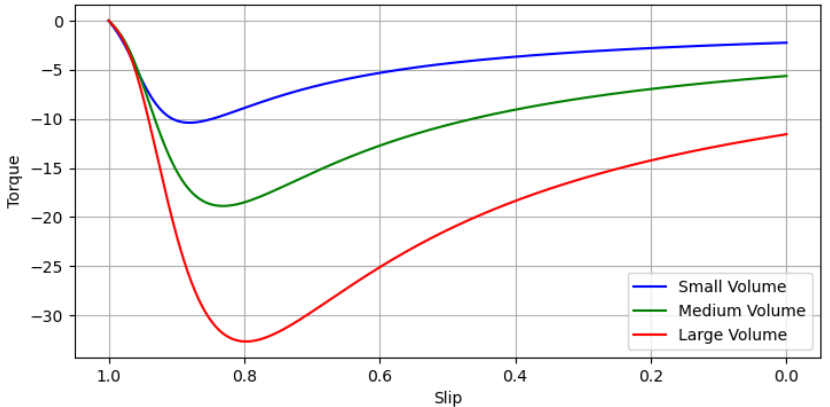
Figure 3. Braking torque for various magnet